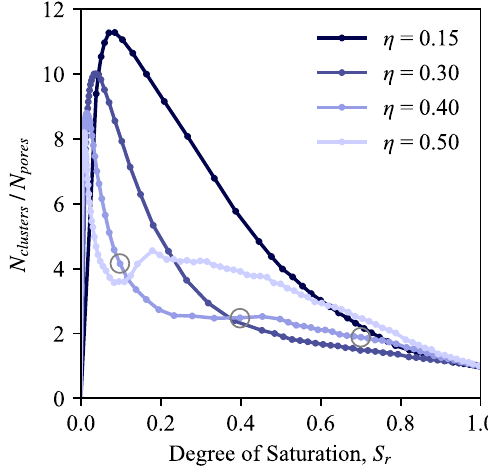
Figure 4. Evolution of normalized number of clusters as a func- tion of degree of saturation, for di ff erent porosities. The circles indicate points at which snapshots of the simulation are provided in Figure 3.